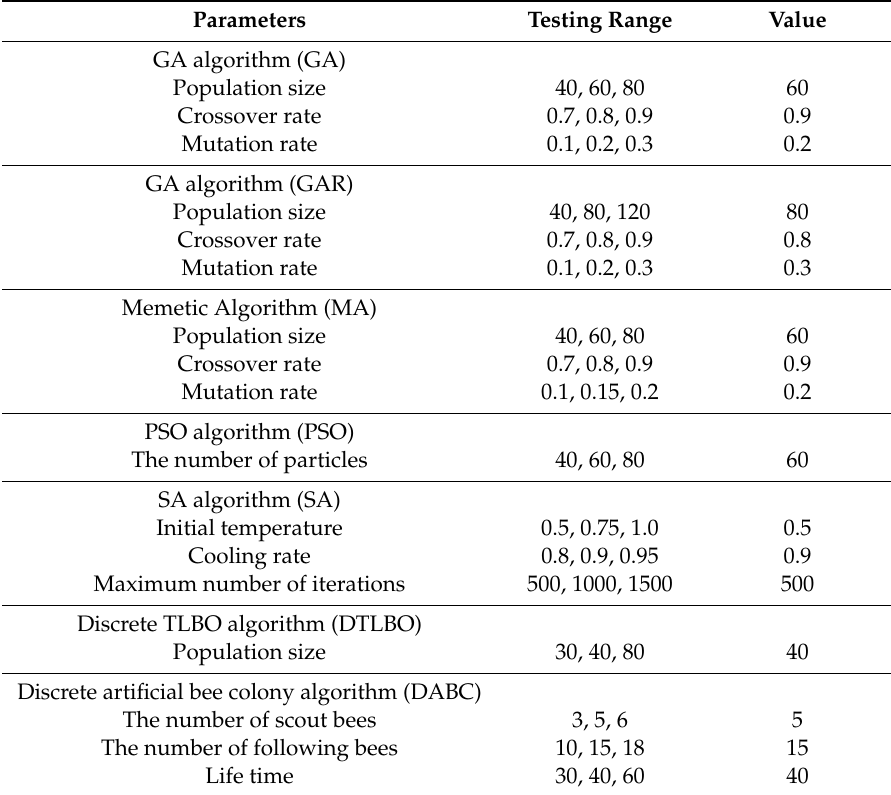
Table 9. Parameter values of the comparison